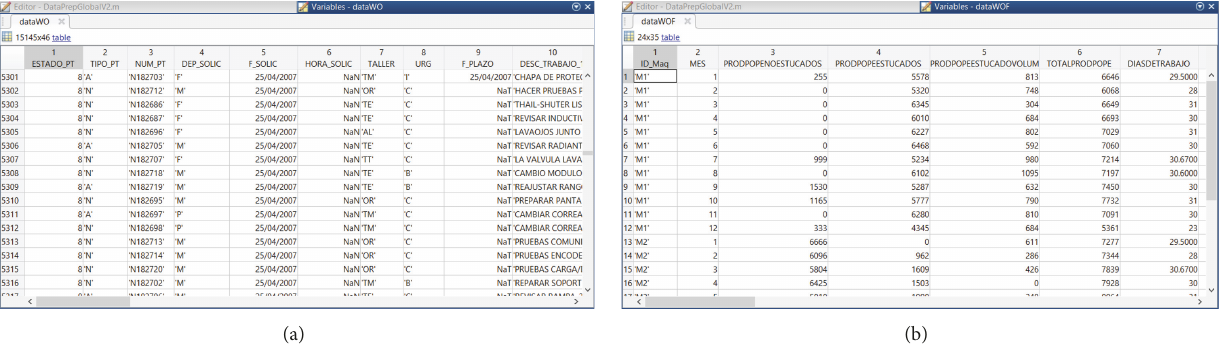
Figure 1: Imported data from CMMS: (a) table dataWO; (b)